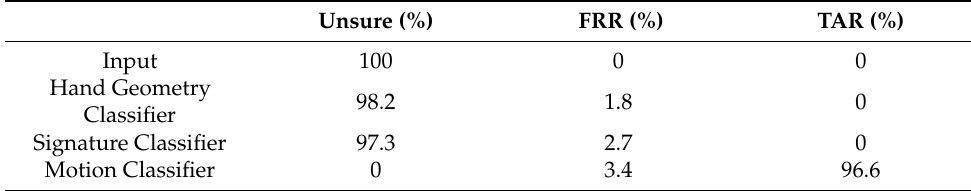
Table 1. Statistic table for genuine data after each step of the classifiers.